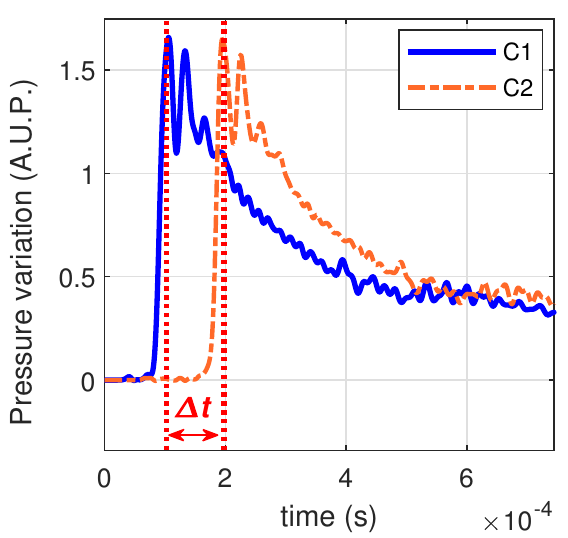
Figure 11. Example of TDOA estimation between two